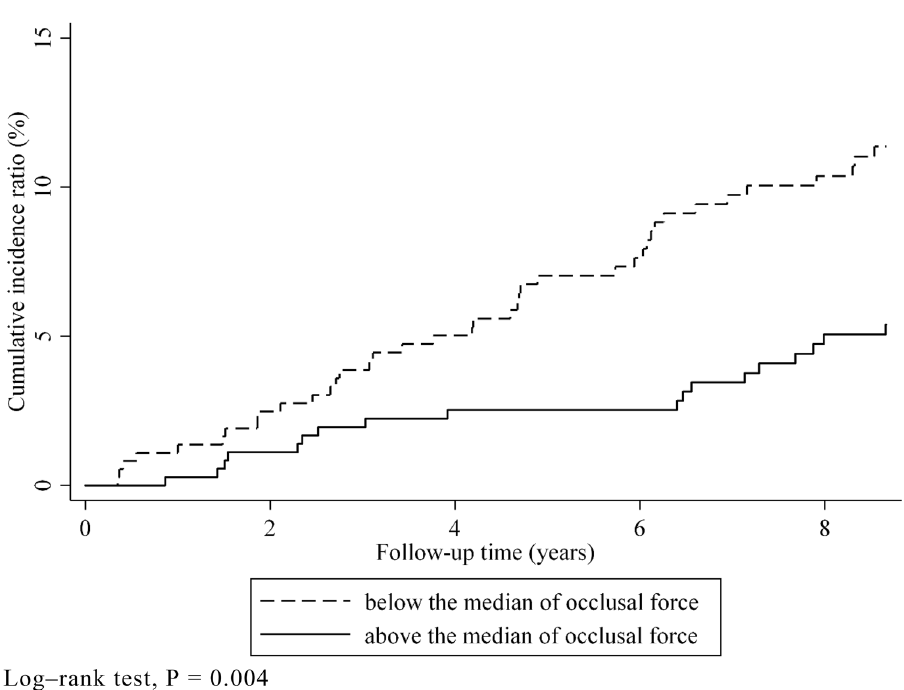
Figure 2. Kaplan–Meier survival curves for the cumulative incidence of gastrointestinal cancer based on the maximum occlusal force (log-rank test, P =